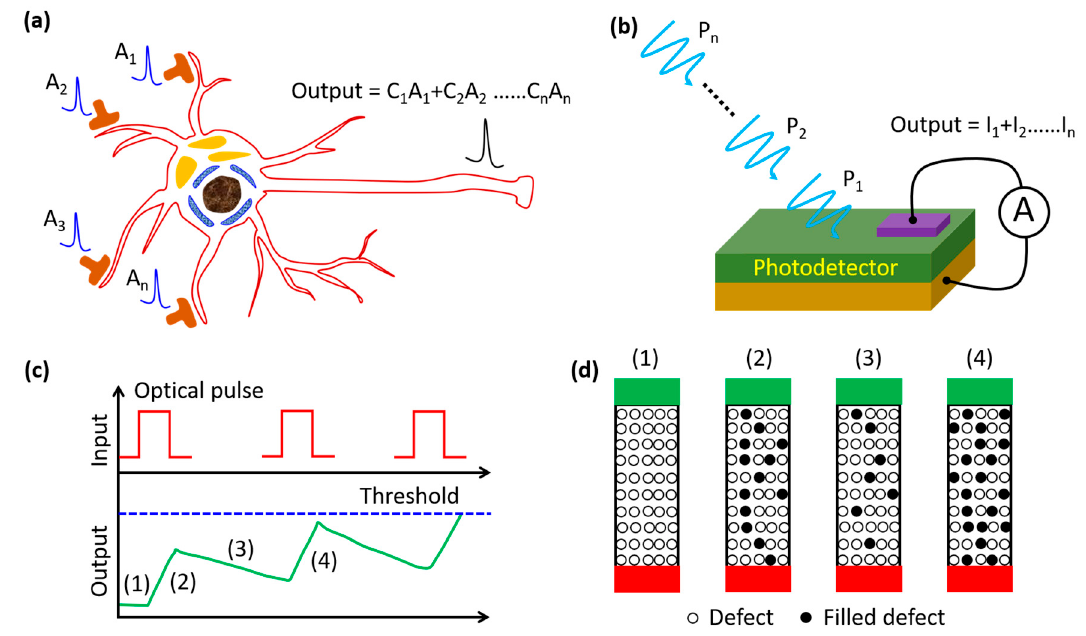
Figure 1. The operation of a bio-neuron and its analogue in the present photodetector. ( a ) Schematic of bio-neuron. Neuron works as an adder and sum all individual inputs (A 1 , A 2 , ... A n ) with its respective weight (C 1 , C 2, ... C n ). ( b ) Schematic drawings (not to scale) of a typical two-terminal photodetector shows response similar to artificial neuron with input optical pulses. ( c ) Response of a photodetector similar to artificial neuron. ( d ) Proposed working mechanism of the new concept optoelectronic device from (1) to (4) show the filling the defect levels with charge carriers.